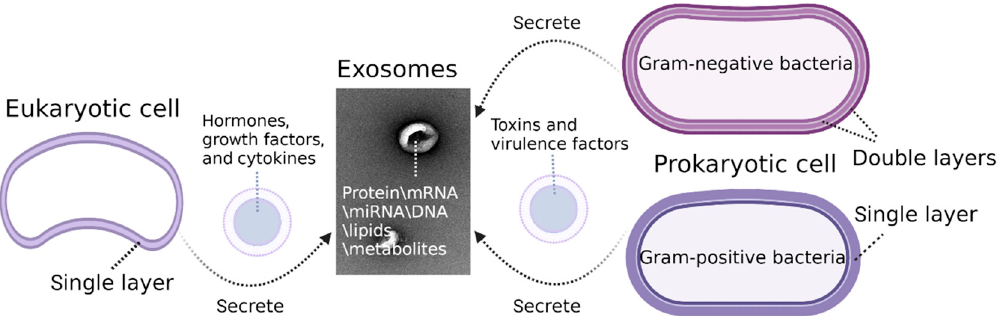
Figure 3. The similarities and differences between eukaryotic and prokaryotic